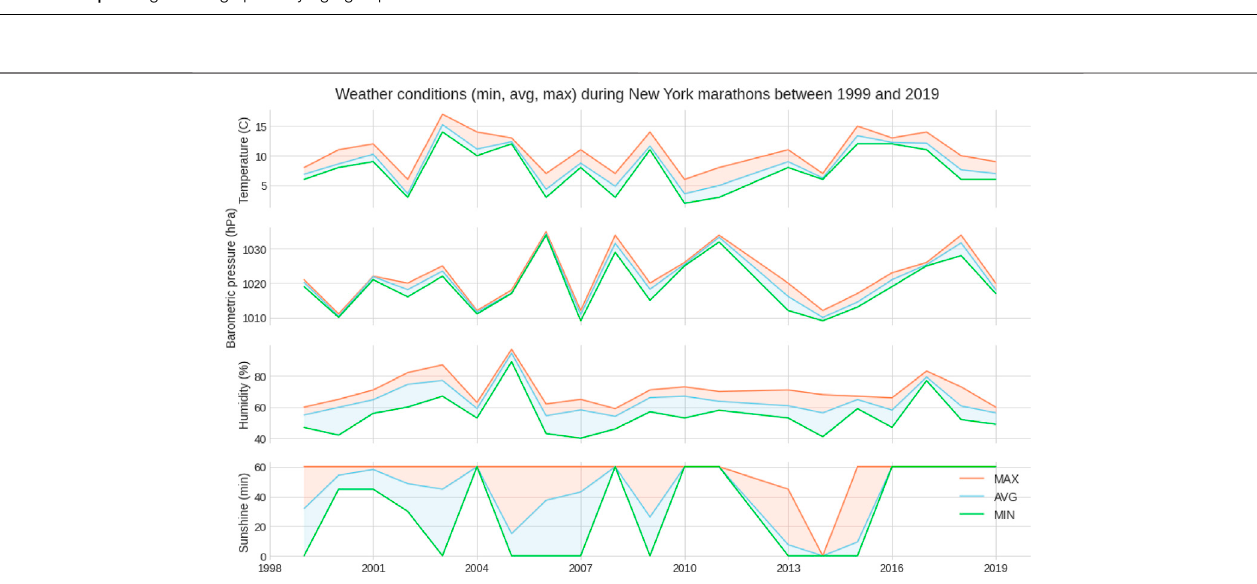
FIGURE 5 | Weather conditions in the “ New York City Marathon ” between 1999 and 2019.